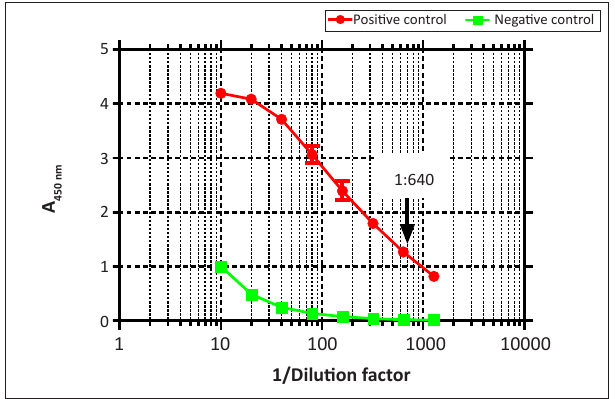
FIGURE 1: Two-fold serial dilution of the recombinant nucleoprotein horseradish peroxidise conjugate on pre-coated ELISA plates to determine the optimal dilution for use in the double-antigen ELISA.